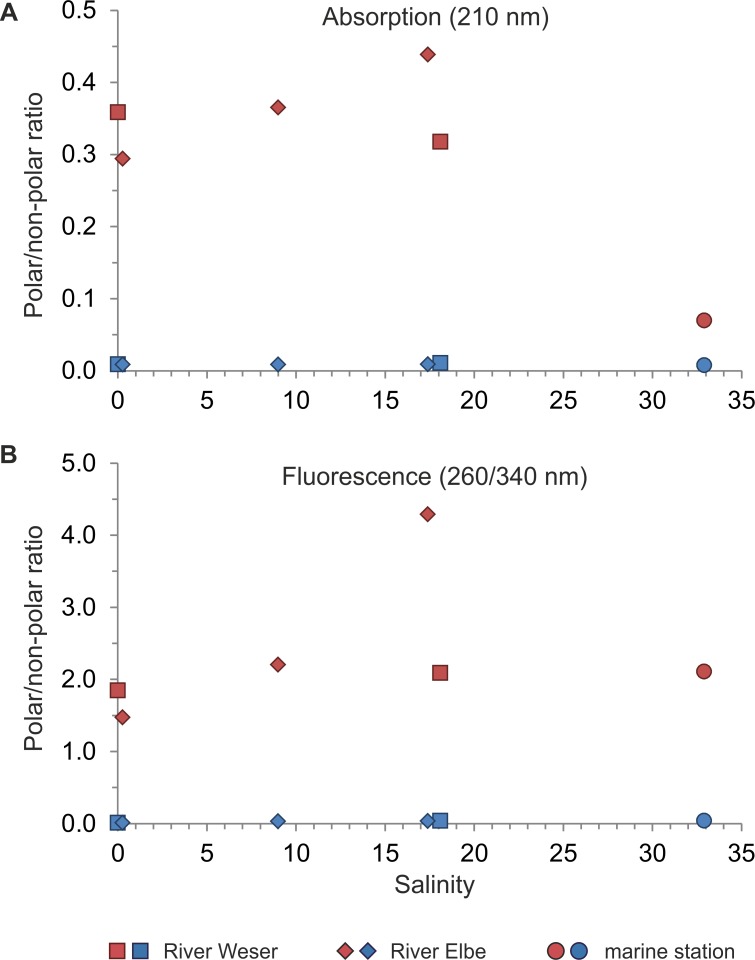
Changes in polar/non-polar peak area ratios of DOMSPE samples with salinity changes.(A) Average polar/non-polar peak area ratios analyzed by UV spectroscopy (DAD210nm) versus salinity and (B) average polar/non-polar peak area ratios analyzed by fluorescence spectroscopy (260/340 nm) versus salinity. The pH 2 extracted samples are indicated by red symbols, pH 8 extracted samples by blue symbols. Symbols represent sampling locations: River Weser (W1, W2; squares), River Elbe (E1 - E3; diamonds) and the marine station (M1; circles).